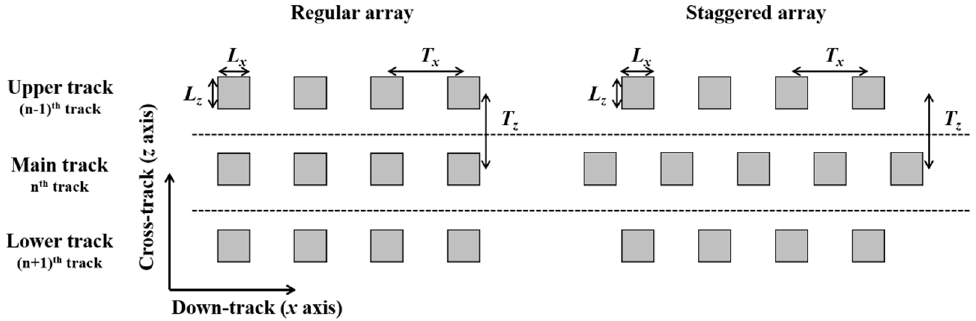
Figure 1. Bit-patterned media (BPM) structures of regular and staggered array.